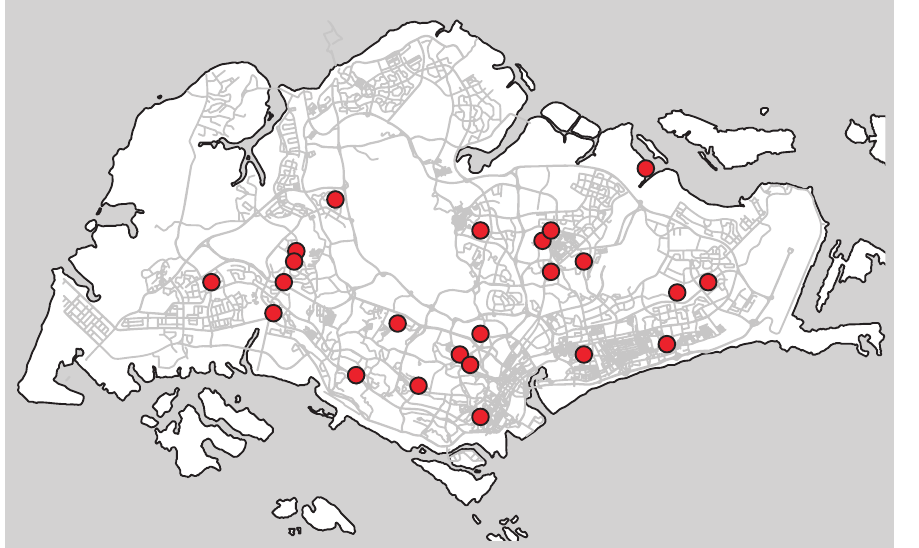
Figure 2. Spot map showing the locations of participating GPFD clinics in Singapore. Most populated parts of the island were represented, the exception being the Woodlands, Sembawang and Yishun areas to the North.